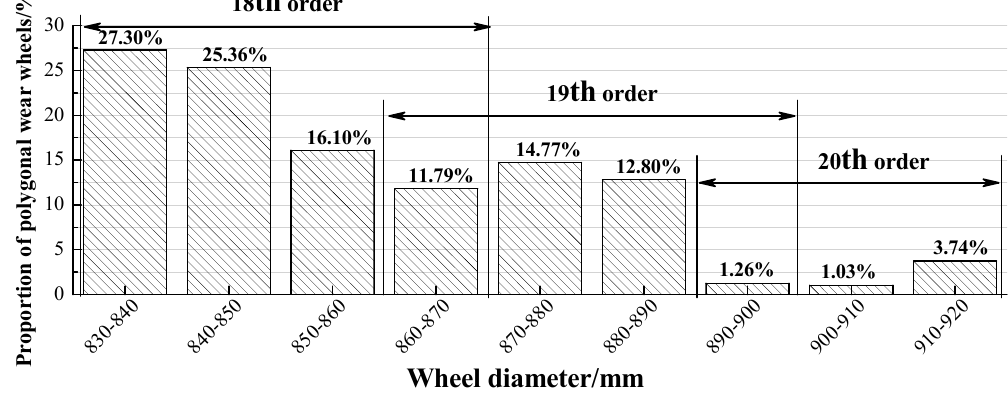
Figure 2. Statistical results of polygonal wheels. Figure 1. ( a ) Test instrument; ( b ) Polygonal wheel.